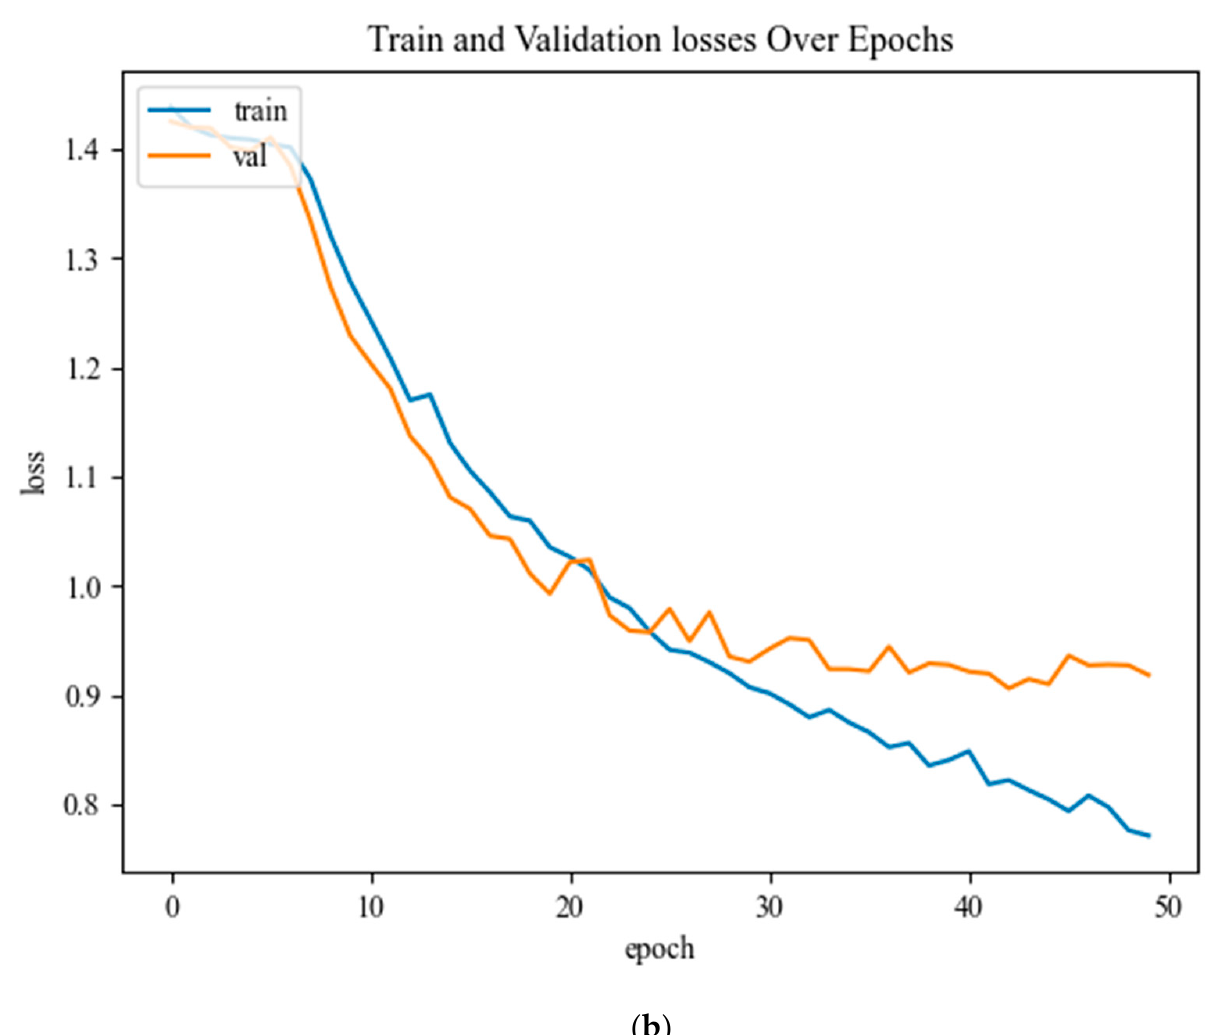
Figure 11. Model performance ( a ) displays the training and validation of accuracy, and ( b ) shows the loss in each period.